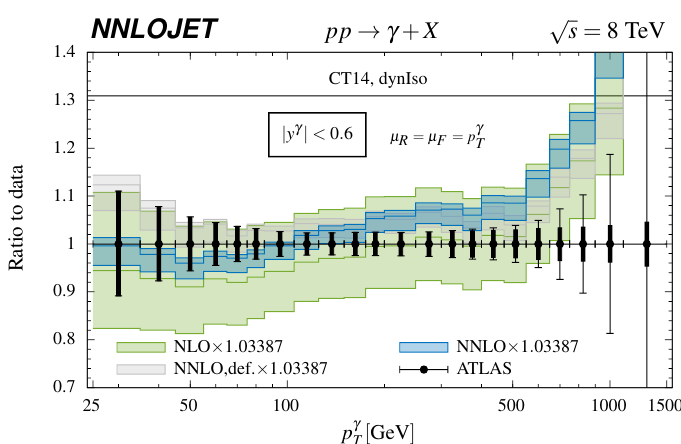
Figure 4 . Ratio to ATLAS data [9] for the transverse energy/momentum of the photon at NLO and NNLO, using the PDF and isolation procedure choice of MCFM [38]. The results are rescaled by a factor of 1 : 03387 to account for the di(cid:11)erent choice of (cid:11) em . The NNLO result obtained using the default PDF and isolation procedure choice is shown in